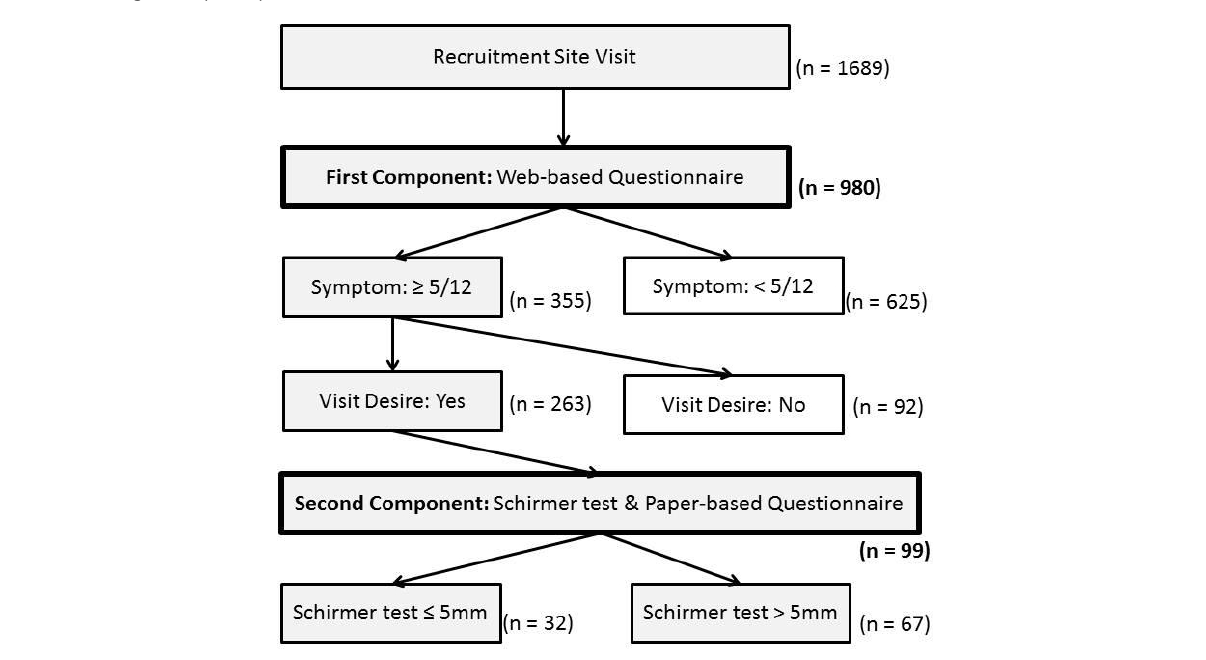
Figure 2. Flow diagram of